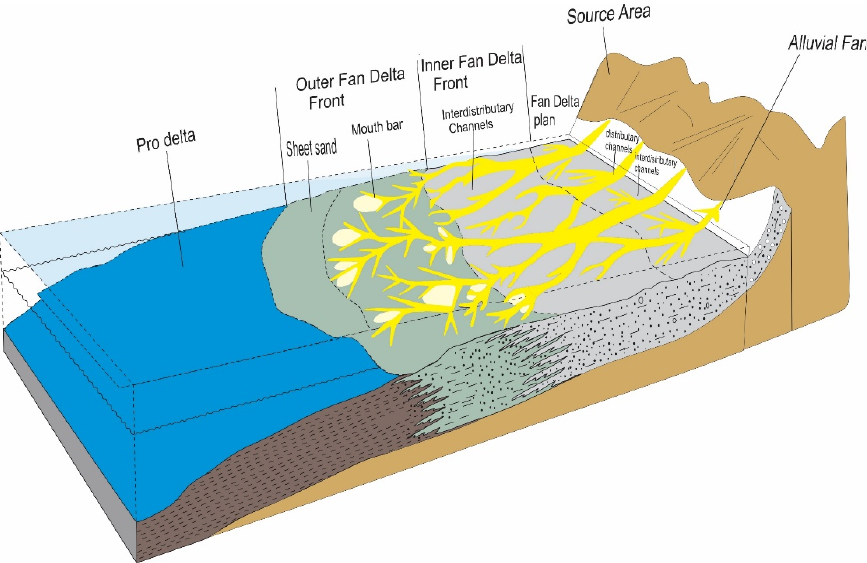
Figure 17. Generalize depositional model of coarse grain or Fan Delta. Variegated mudstones were found in the inner delta front in the northwest direction, containing calcareous contents. It is differentiated from the mudstone in the inner delta front on the basis of color (DGM), and hence interpreted to be occurring in the outer delta front deposits in wells l-9,1-8 and l-10 (Figure 16D). In the inner delta front, we found (GM) and (GGM) deposits. The Es3z6+7 and Es3z8 sand groups are commercially very im- portant for hydrocarbon exploration [18]. These sand groups consist of variegated sand- stones, which contain the deposits of MCS, PCSS, MS, RCL, WCS in Es3z8, and RCS, CFs, BFS lithofacies in Es3z6+7 sand groups, respectively. 6. Conclusions Sandstones of Es3z were analyzed through detailed scrutinization of cores, and in- terpretation of well logs and seismic data. Typical responses of well logs were calibrated with lithological associations and sedimentary structures of cores. Studies of cores and well logs show that the main lithology of reservoir units in the research area are mudstone, muddy sandstone, fine to coarse sandstone and conglomeratic sandstone along with